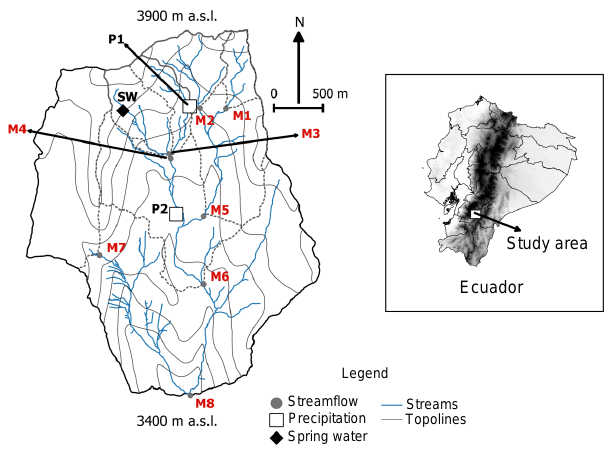
Figure 1. Location of the study area, and the isotopic monitoring stations in the Zhurucay observatory for streamflow ( M ) and pre- cipitation ( P ). SW is a spring water source upstream of the outlet of catchments M3 and